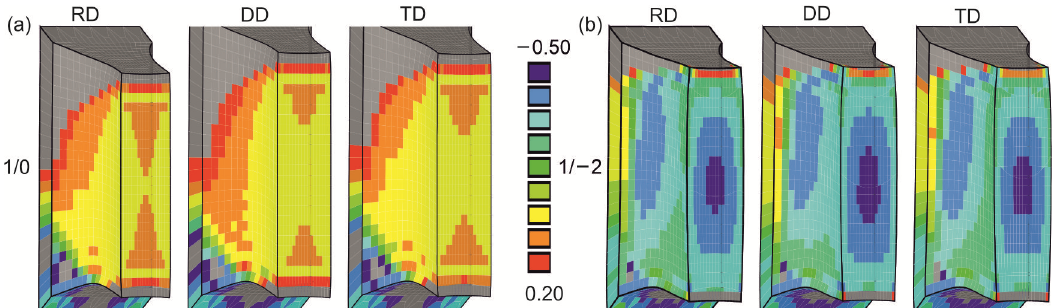
Figure 5. Stress triaxialities: ( a ) load case 1/0 and ( b ) load case 1/–2. The strain fields in the notched region were monitored by digital image correlation (DIC), and the von Mises equivalent strain was chosen as a scalar value to display the corresponding strain fields. Enforced mainly by the displacement-driven machine control, the geometry behaved very symmetrically during the experiments, and only shortly